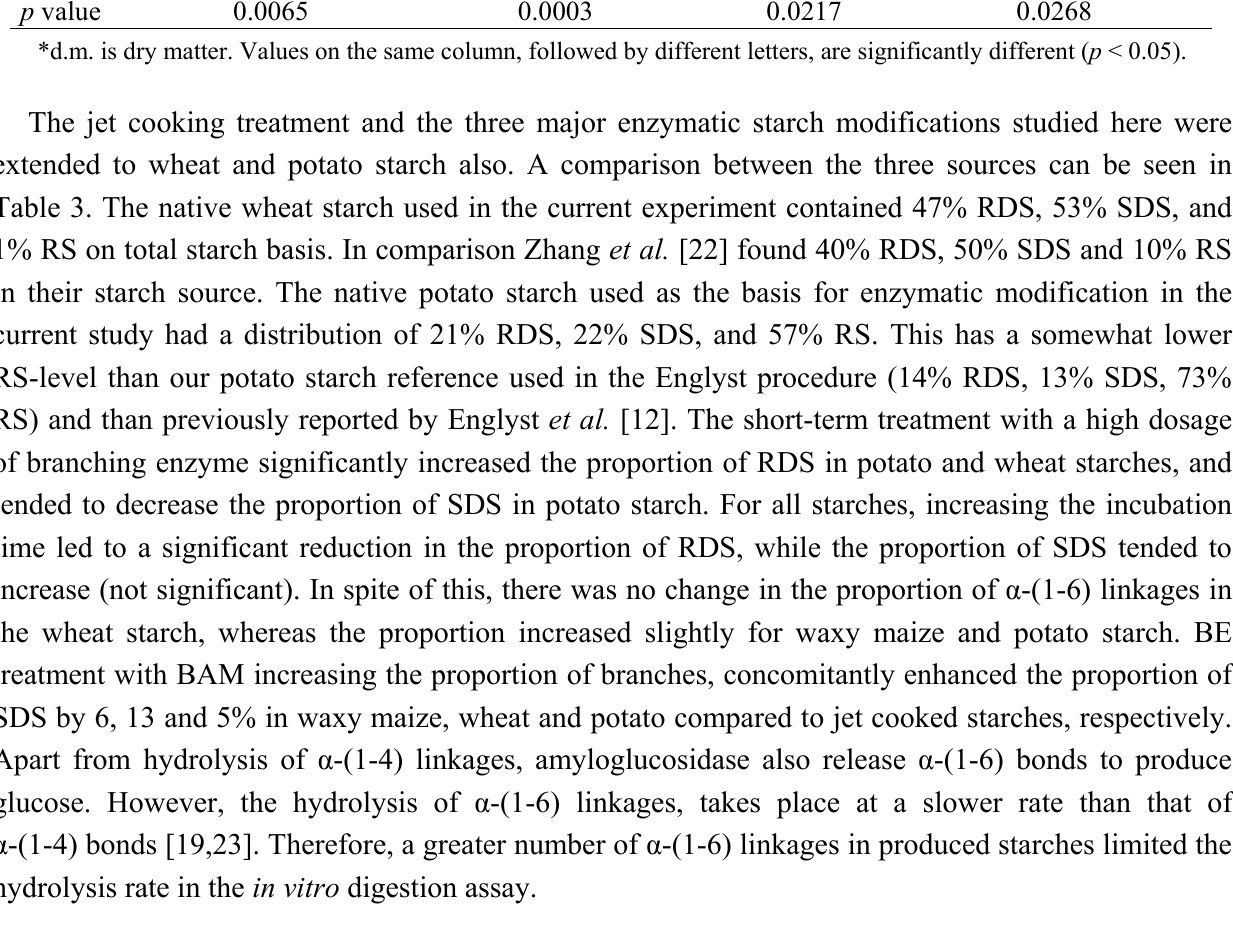
Table 3. The native wheat starch used in the current experiment contained 47% RDS, 53% SDS,